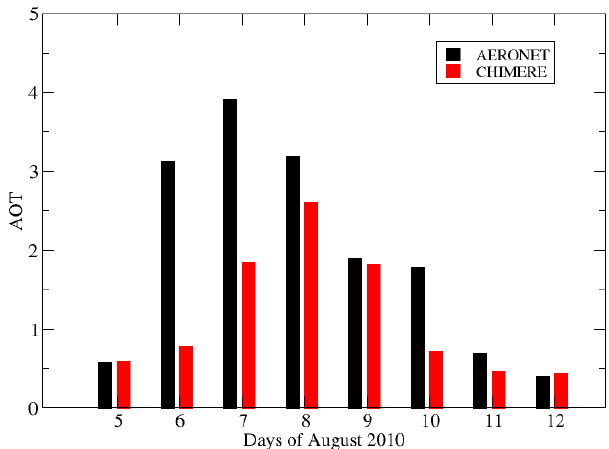
Figure 2. Temporal evolution of the daily mean AOT over Moscow modeled by CHIMERE (at 400nm) and measured by AERONET (at 440nm) between 5 and 12 August